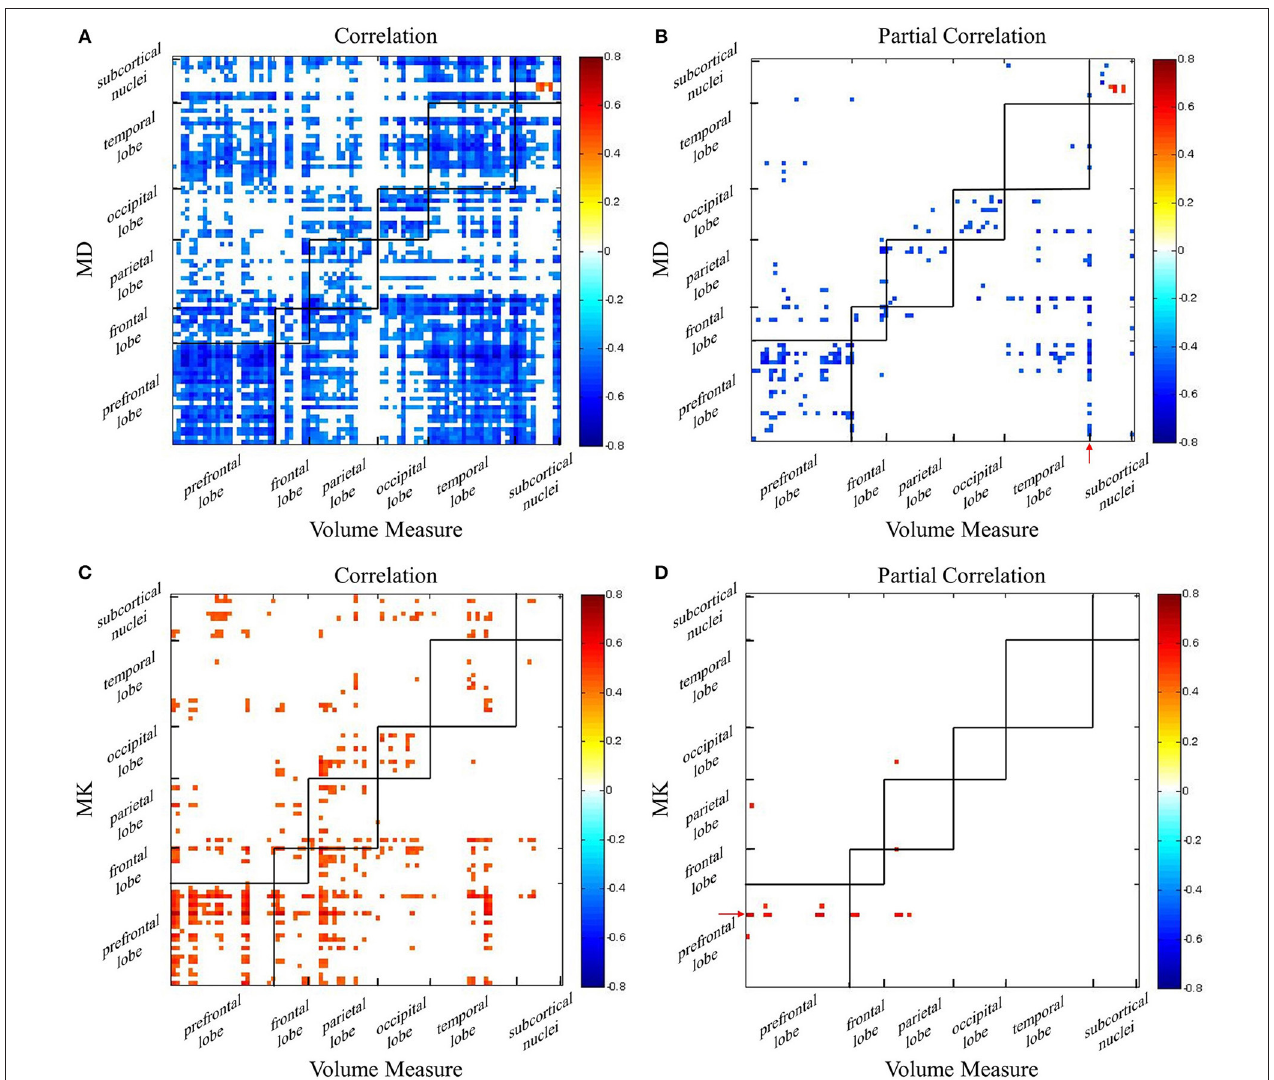
FIGURE 4 | The correlation coefficient maps between GM volume and DKI indexes. Age-dependent association between (A) GM volume and MD and (C) GM volume and MK. Age-independent association between (B) GM volume and MD and (D) GM volume and MK. Red color reflects positive correlation, and blue color reflects negative correlation. The significant level is a FDR corrected p -value <